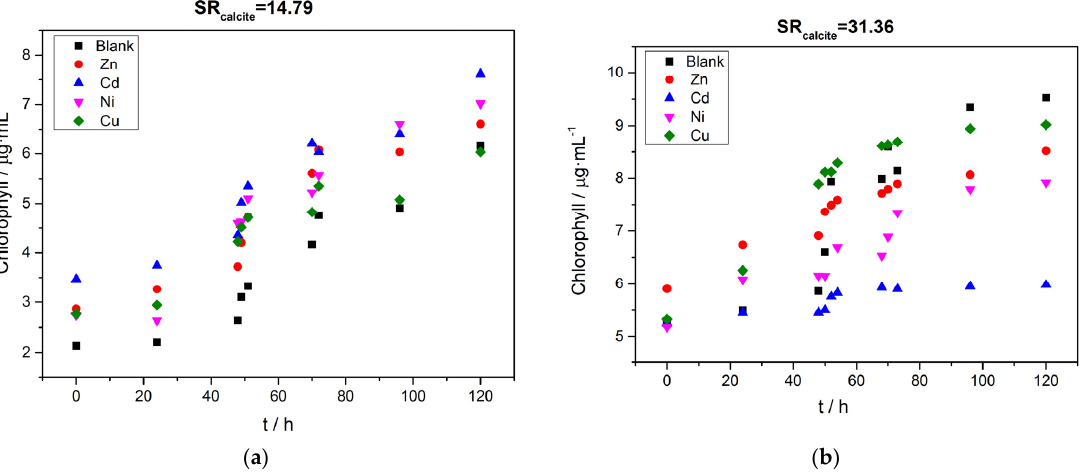
Figure 12. Total chlorophyll concentration in the supersaturated solutions as a function of time during the precipitation of calcium carbonate in the presence of 10 μ M of Zn ( ), Cd ( ), Ni ( ) and Cu ( ), in the presence of active A. obliquus culture under illumination; ( a ) SR calcite = 14.79; ( b ) SR calcite = 31.36; 25 °C, pH 8.50, 0.15 M of NaCl.